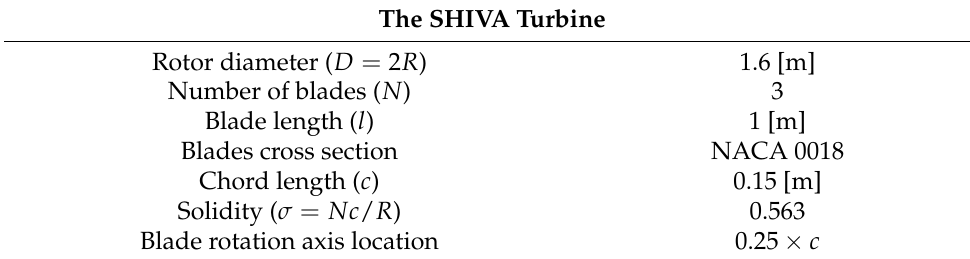
Table 1. SHIVA turbine